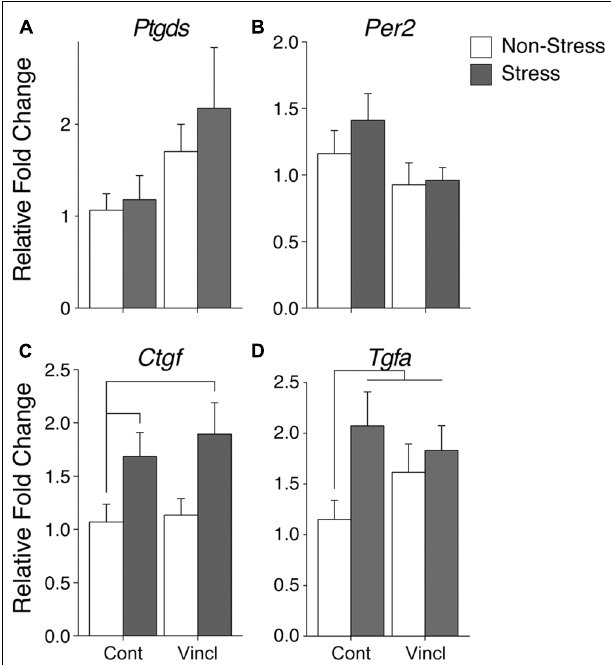
FIGURE 3 | Gene expression in the medial amygdala . Relative gene expression of (A) Growth factor and neuromodulator Ptgds shows a significant effect of ancestral vinclozolin exposure. (B) Circadian rhythm gene Per2 was significantly down regulated by ancestral vinclozolin exposure. (C,D) Growth factors Ctgf and Tgfa show effects of CRS, both up-regulated by CRS during adolescence. Post hoc Ctgf comparisons of C-S andV-S were significantly increased compared to C-NS. All three treatment groups (C-S,V-NS, andV-S) were found to be significantly increased in post hoc analysis of Tgfa . Lines connecting group bars signify a significant post hoc pair-wise test.